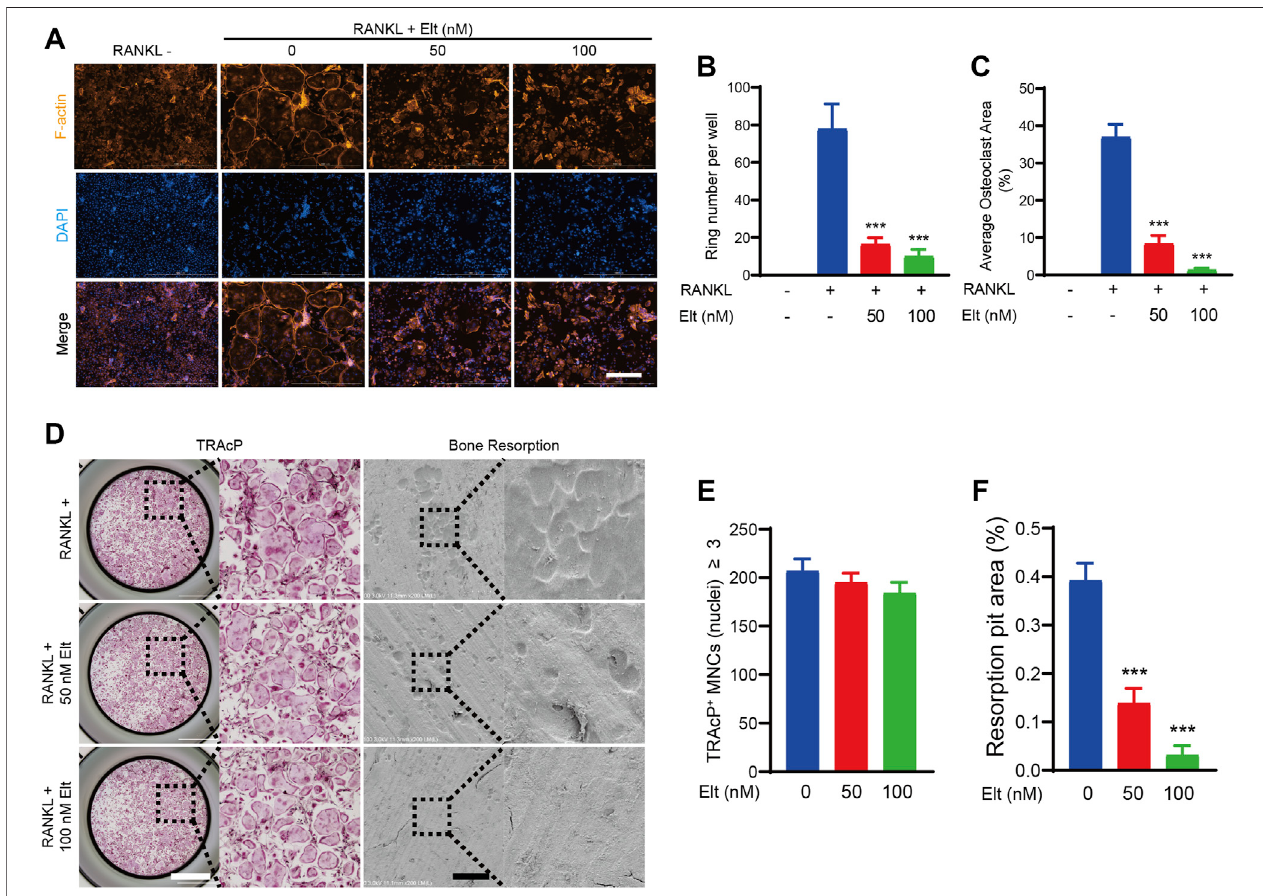
FIGURE3| EltattenuatesformationofF-actinbeltsandbone-resorptionactivityofosteoclasts. (A) RepresentativeimagesofF-actinbeltsformationinosteoclasts treated with different concentrations of Elt. The actin cytoskeleton (Orange red) and nucleus (blue) of osteoclasts were stained (scale = 500 μ M). (B,C) Quanti fi cation of the belts number per well ( n = 3 per group). (D) Representative images of TRAcP staining cells (scale = 1,000 μ M) and bone resorption pits (scale = 500 μ M). (E,F) QuantitativeanalysisofthenumberofTRAcP + cellsperwell(96-wellplate)and resorbedareaonboneslices.Theabove dataareexpressed asthemean±SD; n = 3; *p < 0.05 relative to RANKL-induced